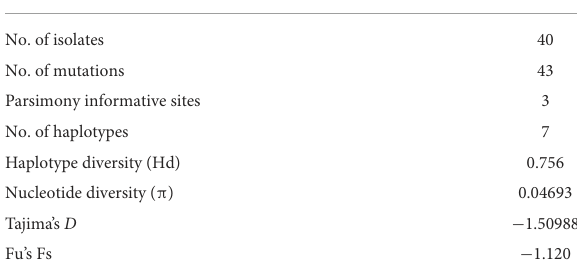
TABLE 3 Diversity and neutrality indices for Paramphistomum populations from